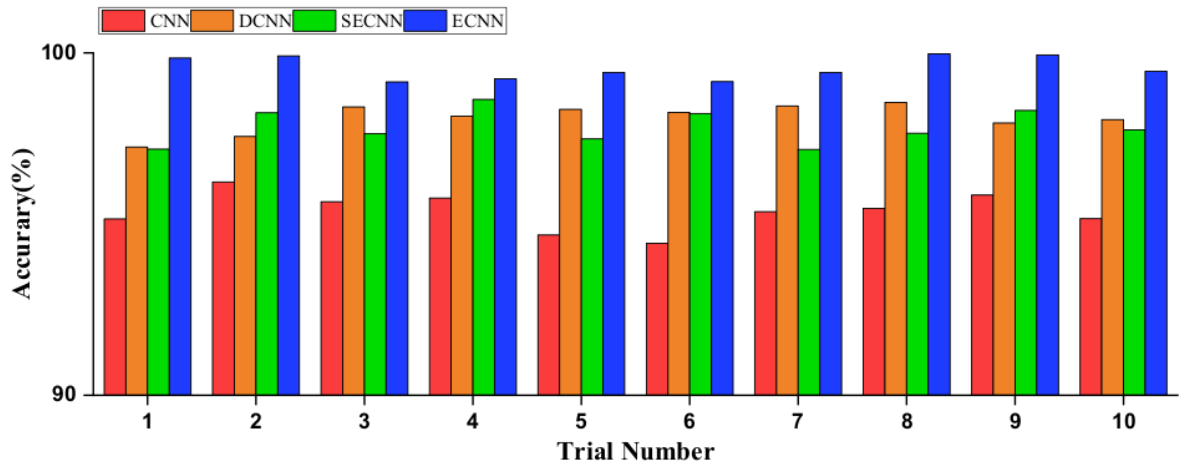
Figure 14. Diagnosis results of the ten trials using different methods.